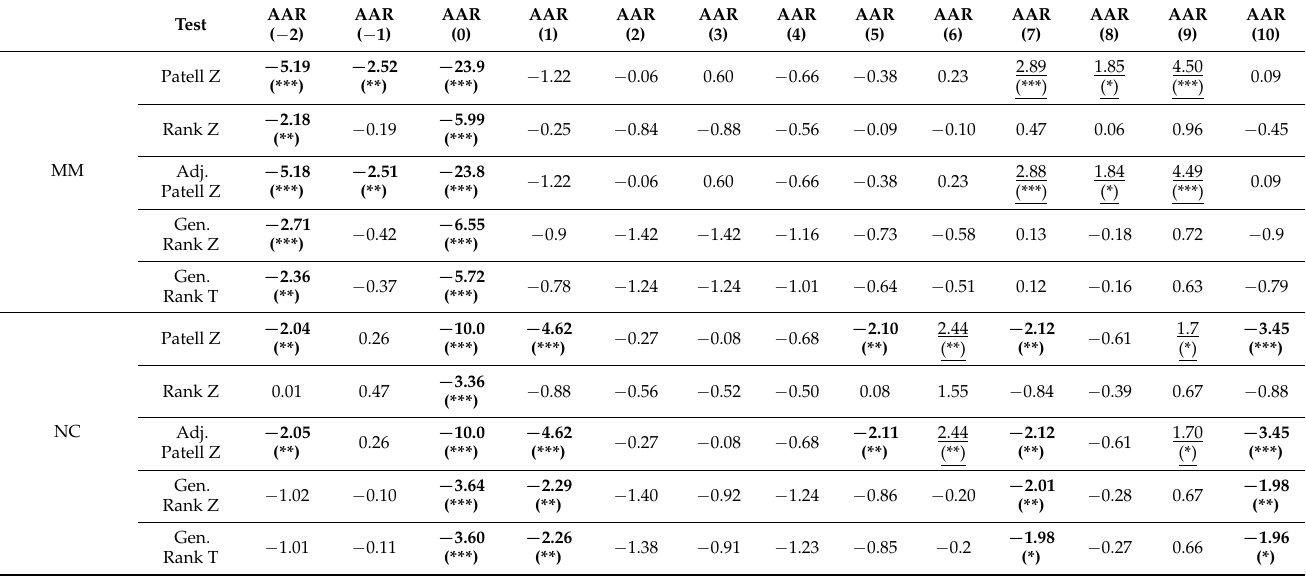
Table 7. The values of test statistics for the performed test (Option 3).